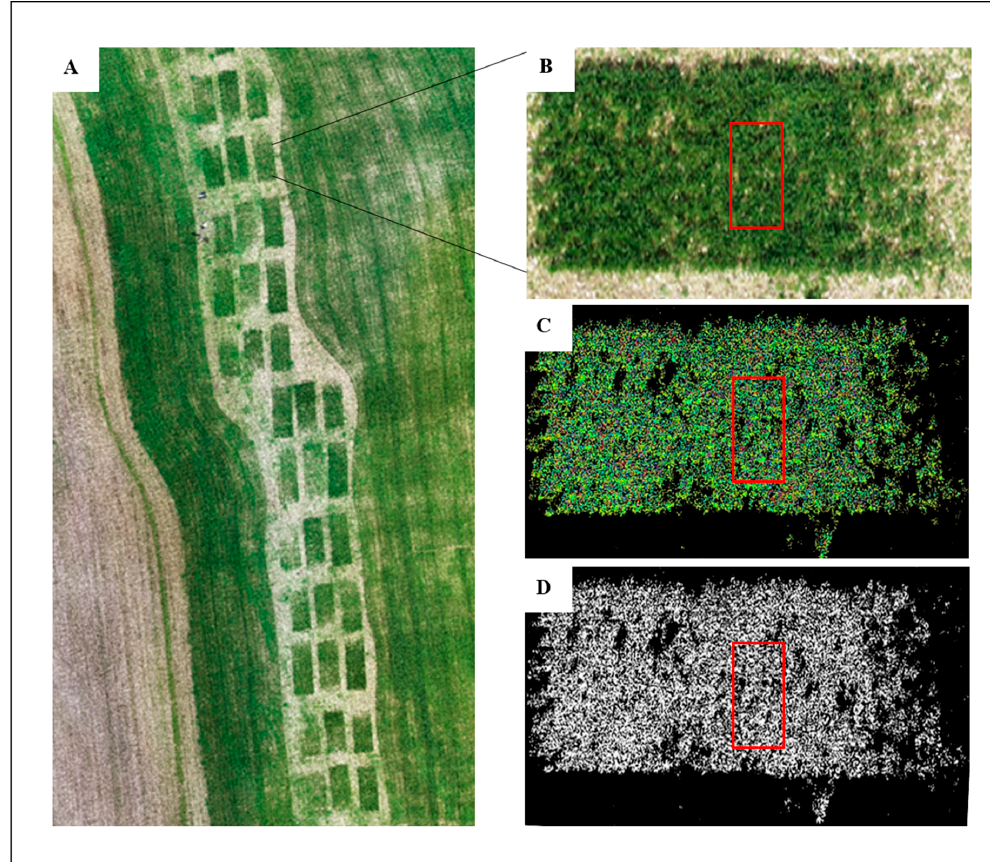
Figure 4. Main phenotyping stages extracted from the UAV in the field experiment. ( A , B ) Stitching the originally acquired images to orthomosaics and placing the treatment plots polygons respectively. ( C ) Extraction of the plot average ExG value and ( D ) projected shoot area (PSA) following the soil/crop classification.